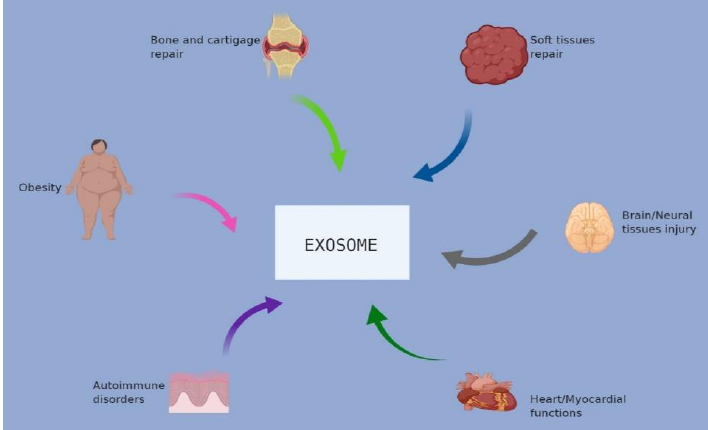
Figure 2. Applications and use of exosomes in different disease conditions.